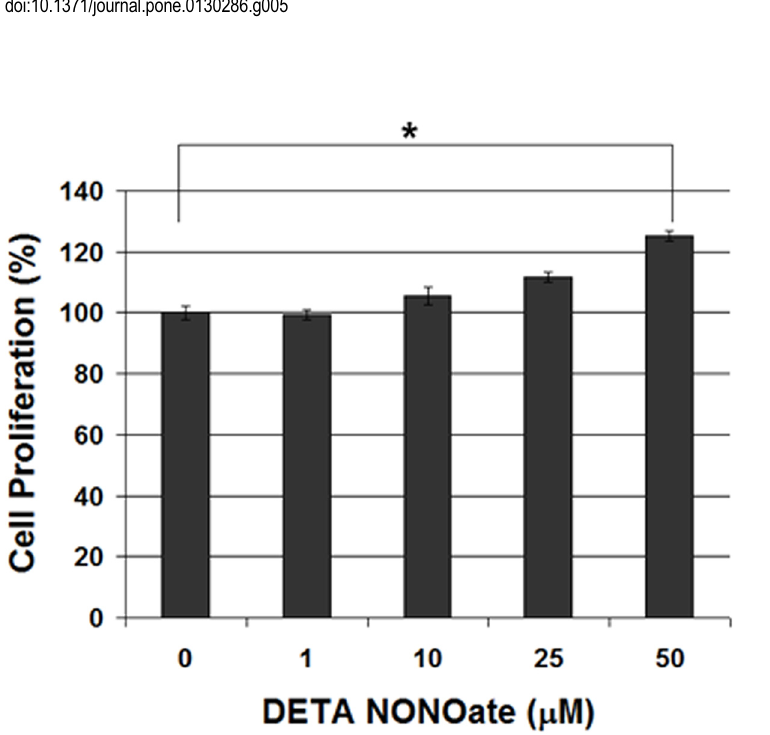
Fig 6. Treatment of MDA-MB-231 cells with DETA NONOate results in a increase of growth, MTT assay was performed after 72-hour treatment.